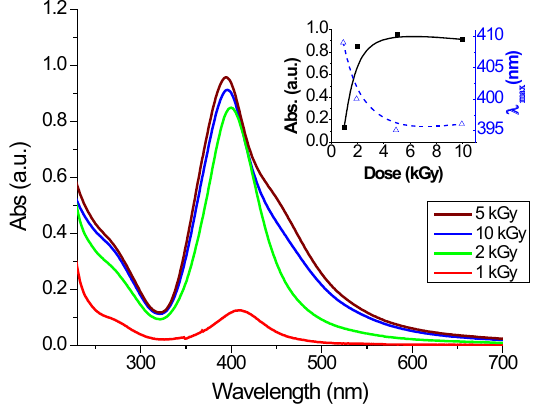
Figure 4. The UV-VIS spectra for the samples obtained by irradiation at low dose rate and IPA-PVA composition. Inset: the effect of radiation dose on the absorption peak